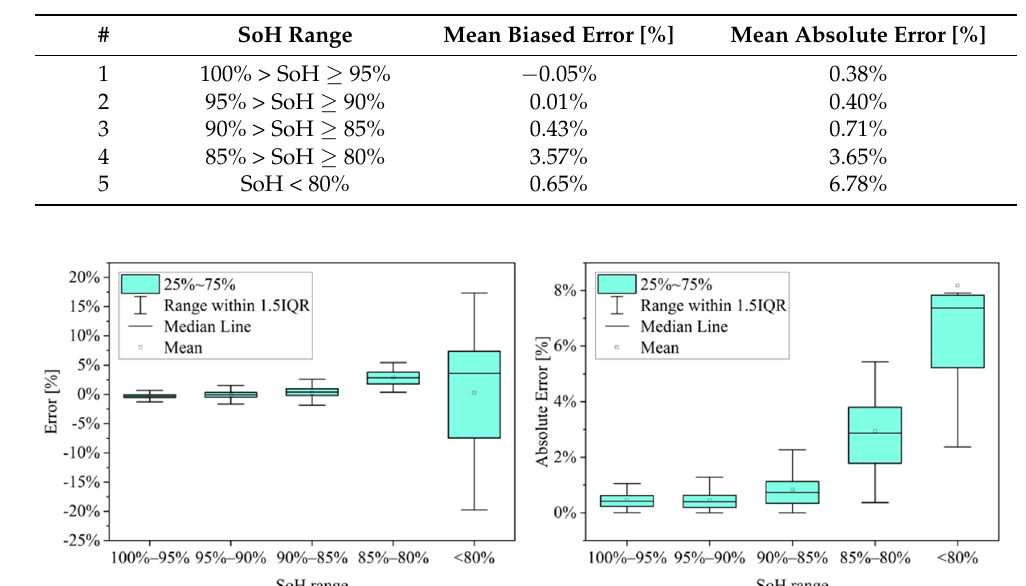
Table 5. MBE and MAE in different SoH ranges for all the combinations of 5 training cells and 5 validation cells.